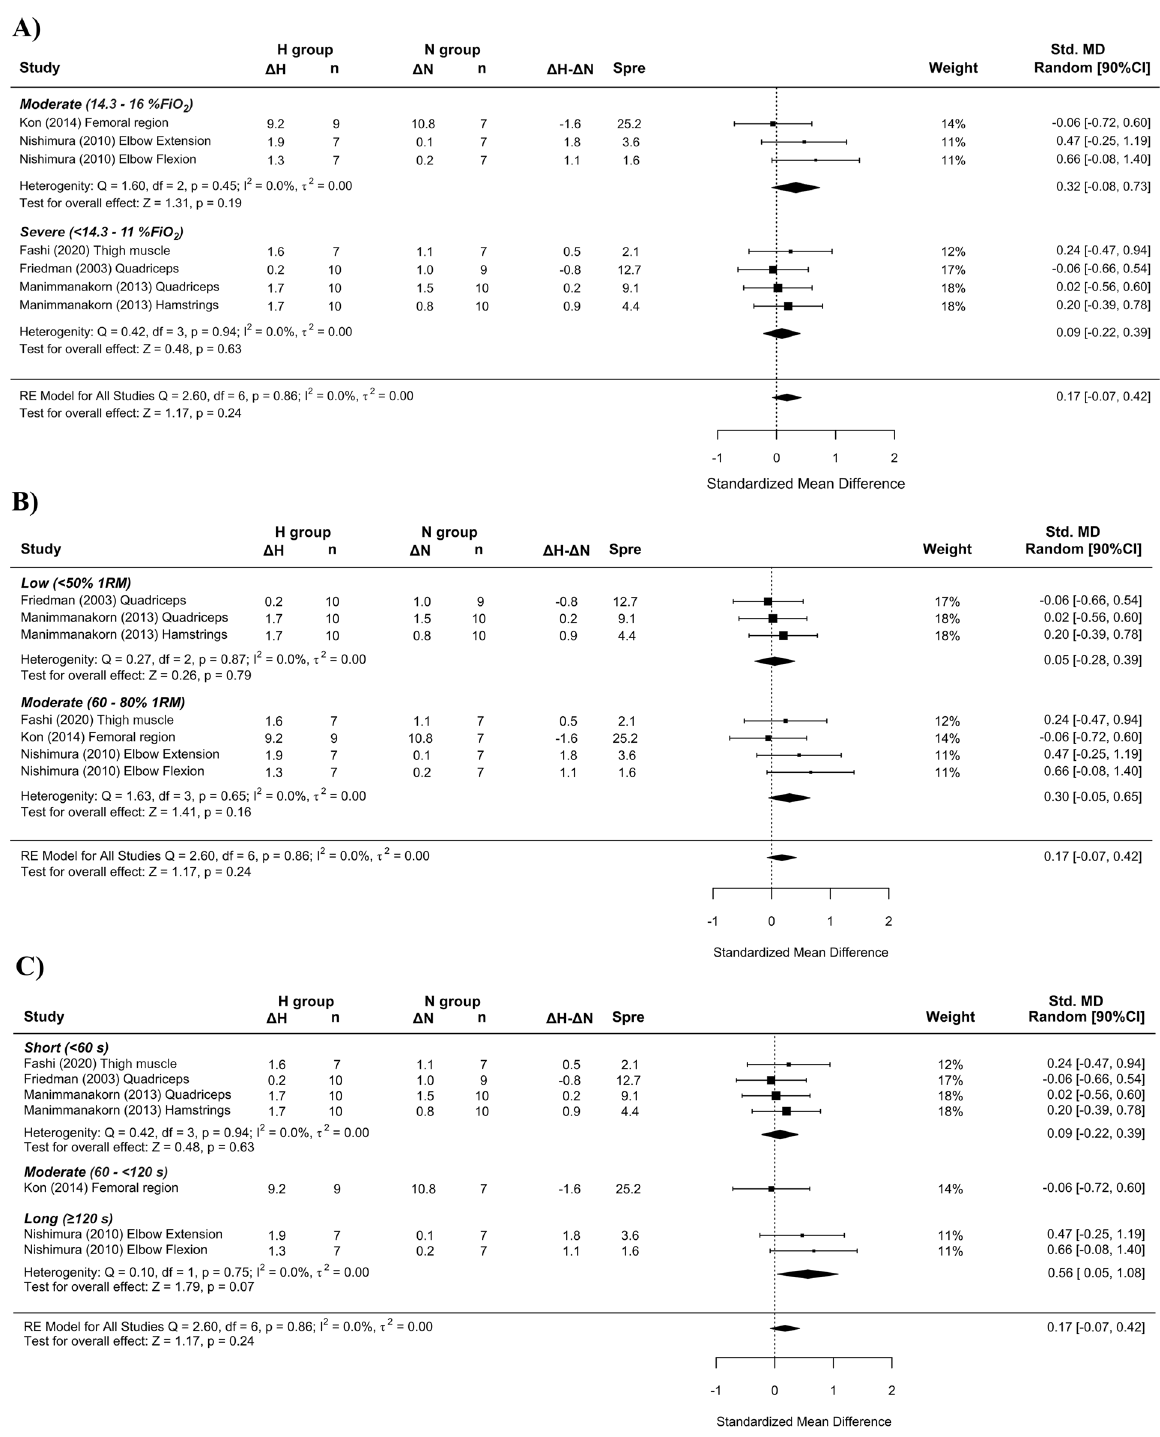
Figure 3. Forest plot of the standardized mean differences of the resistance training program between- conditions (hypoxic [H] group vs. normoxic [N] group) on CSA, subanalysed by: ( A ) severity of the hypoxia; ( B ) training load; and ( C ) interset rest interval. Δ: mean differences between post–pre in H and N or between H-N; n: sample size; Spre: mean baseline standard deviation; Std. MD: standard mean difference; RE: random effect’s model; CI; confidence interval; FiO 2 : fraction of inspired oxygen; 1RM; 1 repetition maximum; Q: test statistic for the test of heterogeneity; df: degrees of freedom; p : p value; I 2 : I 2 test; τ 2 : tau 2 test; Z: z